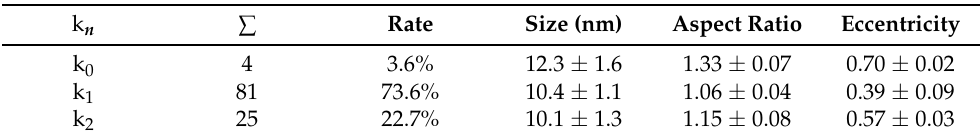
Table 3. Clustering summary for the iron nanocubes size and shape analysis. k n is the cluster number, ∑ and rate are the number and the fraction of particles for each cluster. Size, aspect ratio and eccentricity represent the mean size (diameter), the mean aspect ratio and the mean eccentricity of the particles for each cluster.